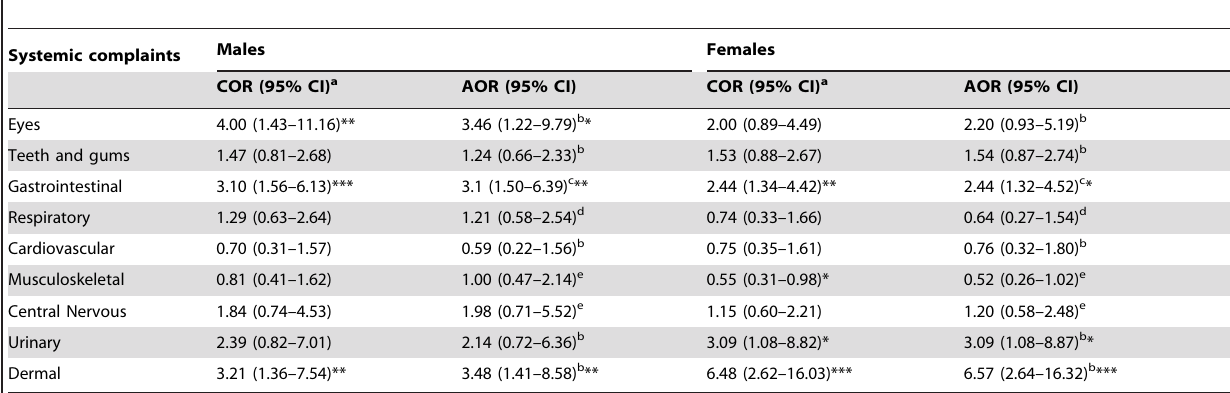
Table 3. Crude odds ratios (COR) and adjusted odds ratios (AOR) for association between self-reported systemic health complaints and residence at Cr (VI) contaminated communities.